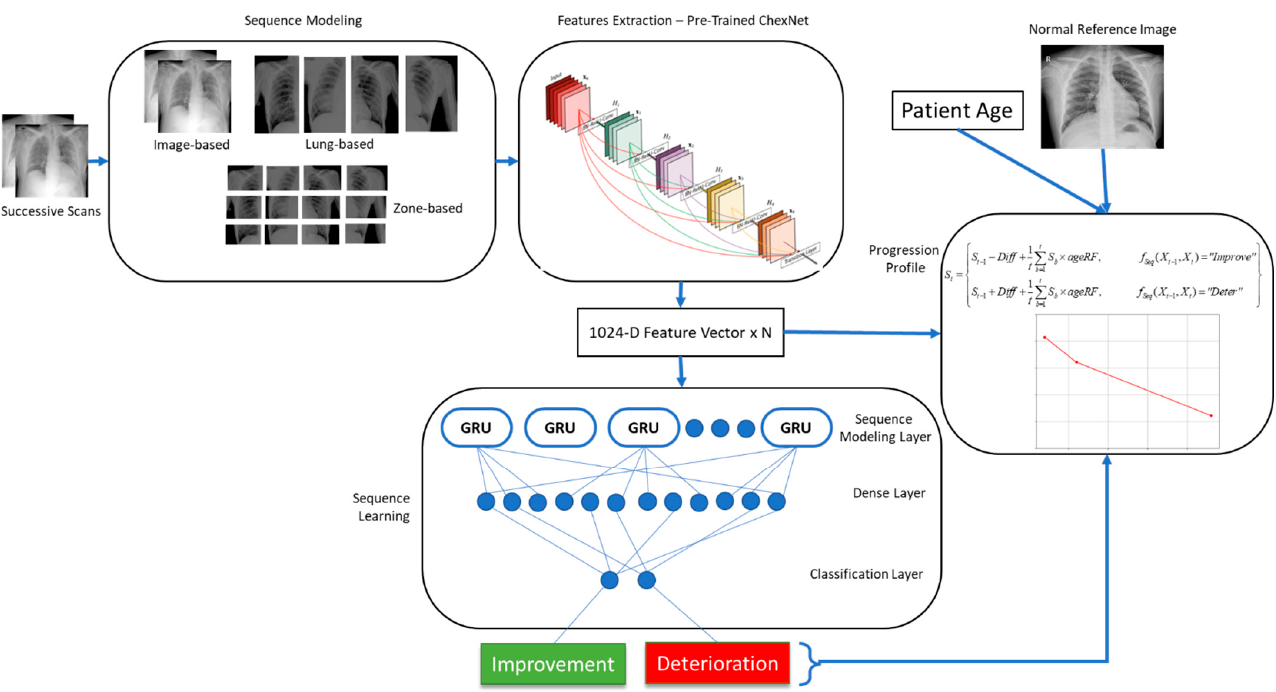
Figure 2. Proposed disease progression detection framework.